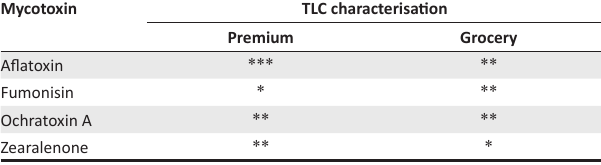
TABLE 3: The results of thin layer chromatography